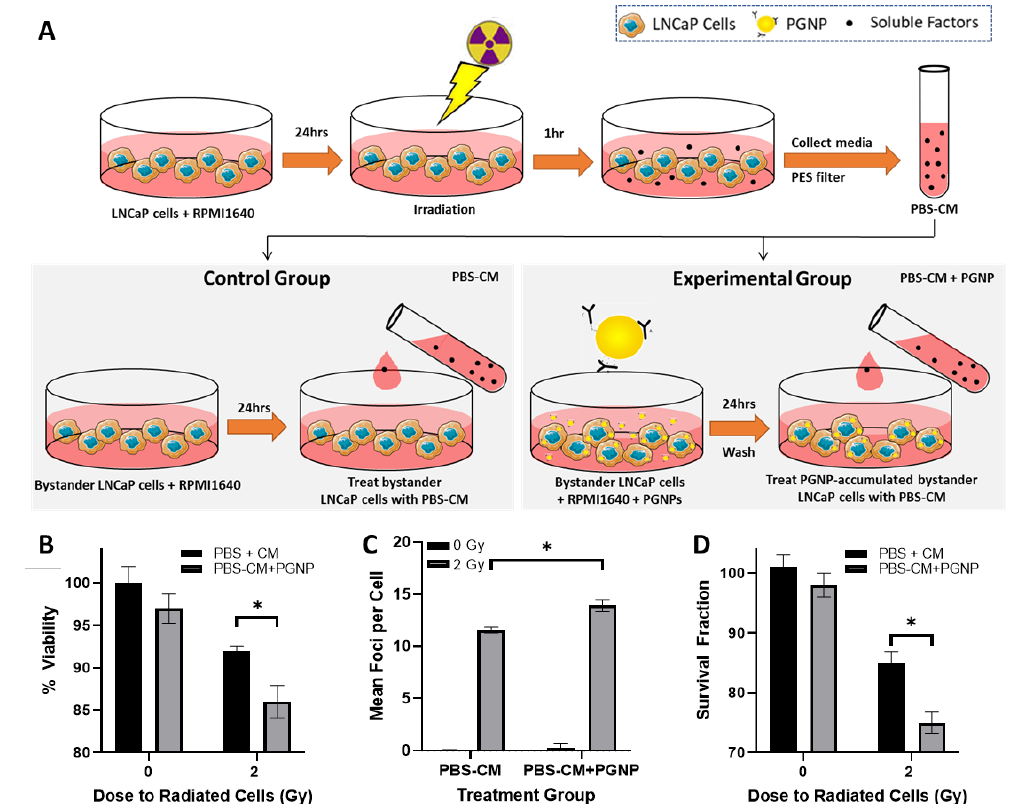
Figure 4. ( A ) Workflow of the conditioned medium transfer procedure in order to investigate the effect of PGNPs on the susceptibility of LNCaP bystander cells to RIBE damage. ( B – D ) MTT cell viability, γ H2AX, and clonogenic assays of bystander cells under different treatments: 0 Gy-PBS-CM: 0 Gy-PBS-CM on bystander cells pretreated without PGNPs; 0 Gy-PBS-CM+PGNPs: 0 Gy-PBS-CM treatment on bystander cells pretreated with 250 µg/mL PGNPs; 2 Gy-PBS-CM+PGNPs: 2 Gy-PBS-CM on bystander cells pretreated without PGNPs; 2 Gy-PBS-CM+PGNPs: 2 Gy-PBS-CM on bystander cells pretreated with 250 µg/mL PGNPs. * Denotes p < 0.05 from Welch’s t-test.